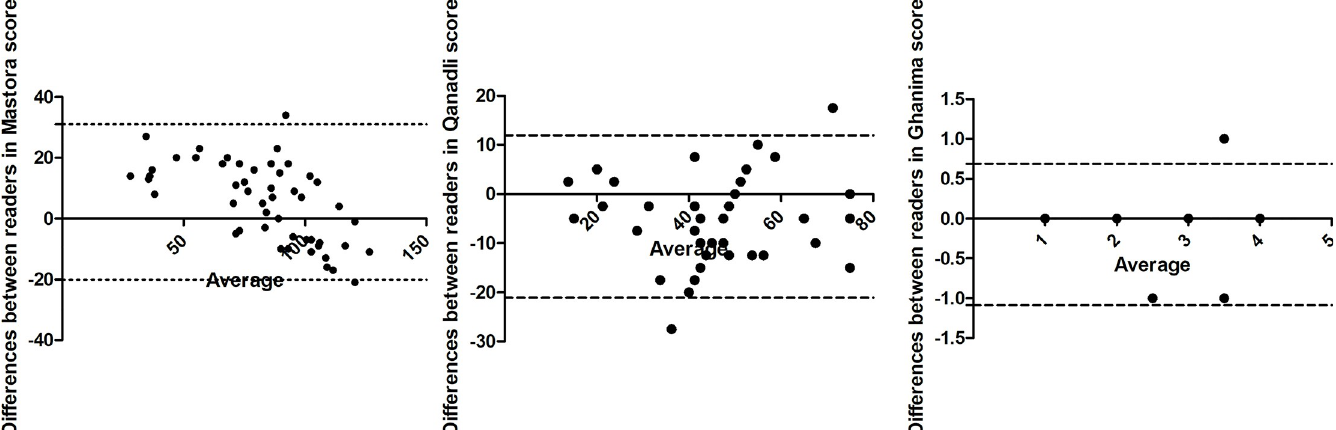
Fig 3. Bland-Altman plots displaying the excellent interreader variability of the scores. The dotted lines indicating the 95% agreement between the readers. A. The plot for Mastora score. B. The plot for Qanadli score. C. The plot for Ghanima score. D. The plot for Kirchner score.